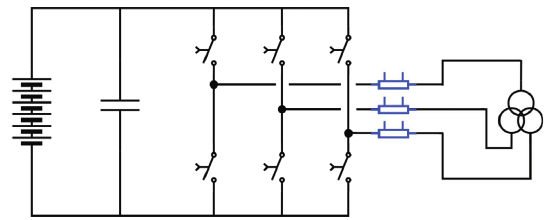
Figure 8: Traction inverter phase current sensing with the shunt resistor-based current